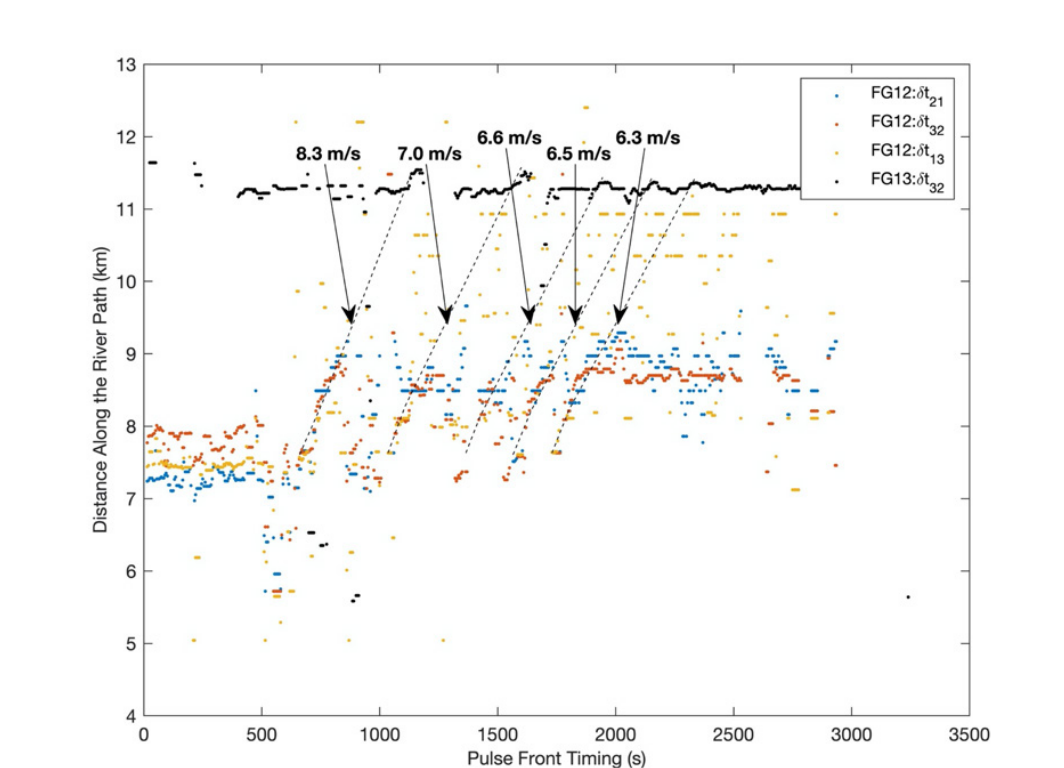
Figure 7: Flow pulse identification at FG12 and FG13. Dashed lines designate the beginning of pulses/surges at both stations as they travel downstream. Calculated flow speeds between FG12 and FG13 show a decrease from 8.3 to 6.3 m ´ 1 over the course of these surges. Refer to Figure 3 for differences in starting times between FG12 and FG13. The y-axis is converted to CFD for each station. The timeline in this figure has been truncated along the x-axis and only high-quality correlations between the data have been plotted for better visualization of the pulses within the lahar. The detectability window of these pulses at both stations is 7.4–9 km at FG12, and 11.2–11.5 km at